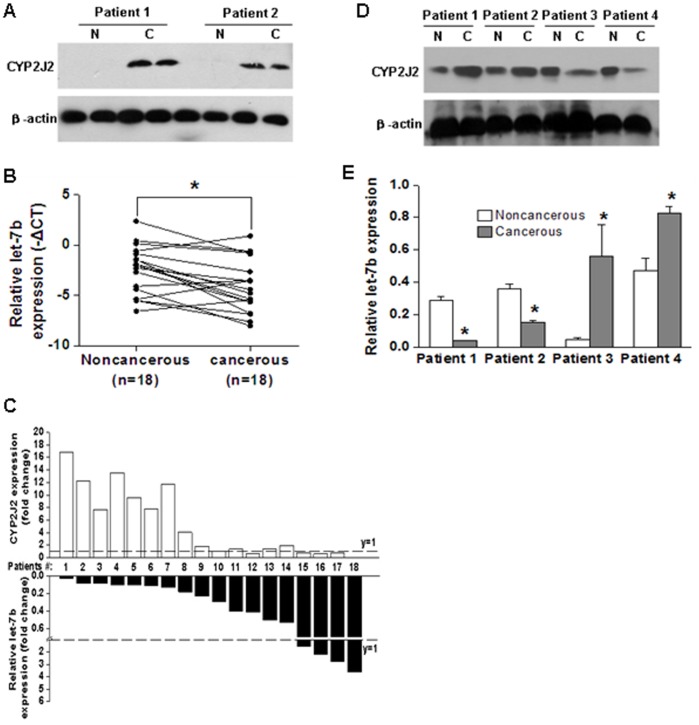
Relationship between CYP2J2 protein and let-7b expression in lung cancer and adjacent nontumor tissues.
A, expression levels of CYP2J2 in lung cancerous (C) and adjacent nontumor tissues (N) was measured by Western blot analysis. B, comparison between the expression levels of let-7b in lung cancerous and adjacent nontumor tissues (n = 18). Although changes of −ΔΔCT values [−(ΔCTnon-tumor tissue−ΔCTcancer tissue)] are relatively mild (from -1.85 to 5.4, 2.6±1.27), the fold changes of let-7b expression between 18 paired human lung squamous cancer and adjacent nontumor tissues are significant (from 0.277 to 42.22, 6.06±2.43). C, relationship between CYP2J2 protein and let-7b expression in lung cancer and paired adjacent nontumor tissues. Expression level of CYP2J2 protein was increased in 13 of 18 sets of lung cancer compared with the adjacent normal tissues (the fold change>1). As expected, let-7b levels were commonly reduced in these tumors compared with the adjacent normal tissues (the fold change<1). D–E, expression levels of CYP2J2 and let-7b in breast cancerous and adjacent nontumor tissues (n = 4). Real-time RT-PCR was used to determine mature let-7b levels. The U6 snRNA expression level was used to normalize the relative let-7b level. Columns, mean of three experiments; bars, SD. *, P<0.05.